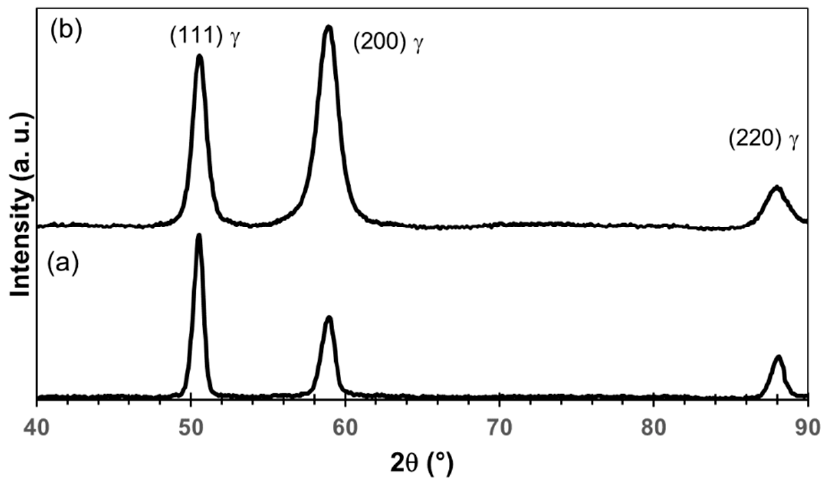
Materials 2022 , 15 , x FOR PEER REVIEW Figure 9. X-ray diffraction patterns of un-annealed ( a ) lowly-deformed and ( b ) 85%-rolled samples.